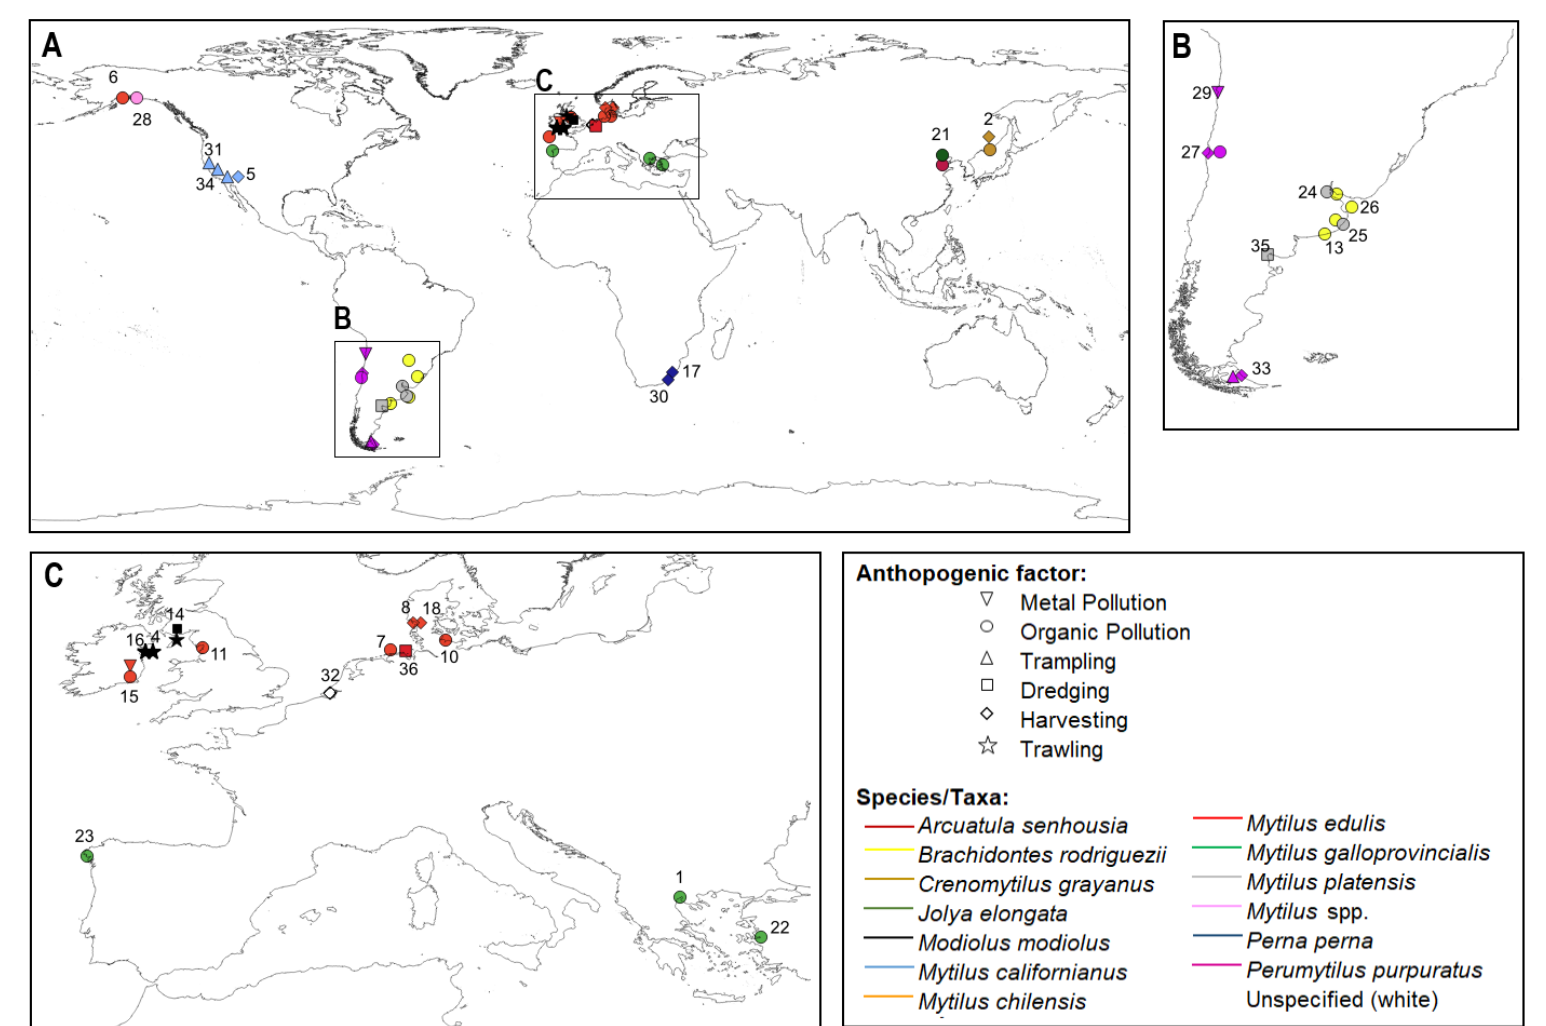
Figure 1. ( A )—Study distribution around the world with indication of each anthropogenic descriptor and taxa investigated; ( B )—Detail of studies conducted in South America; ( C )—Detail of studies held in Europe. Numbers identify the reference studies included in the review.